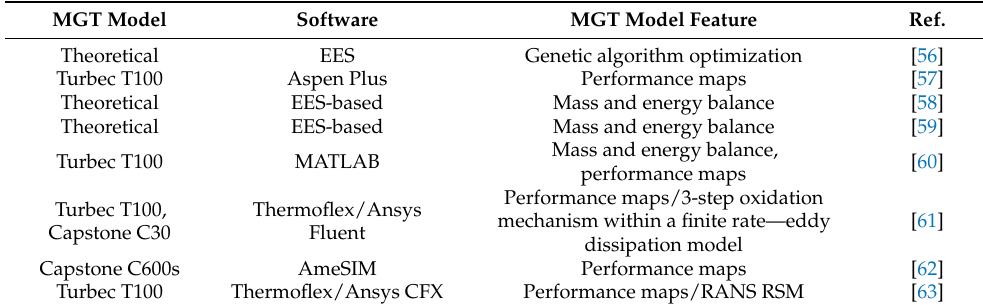
Table 4. Summary of MGT-ORC